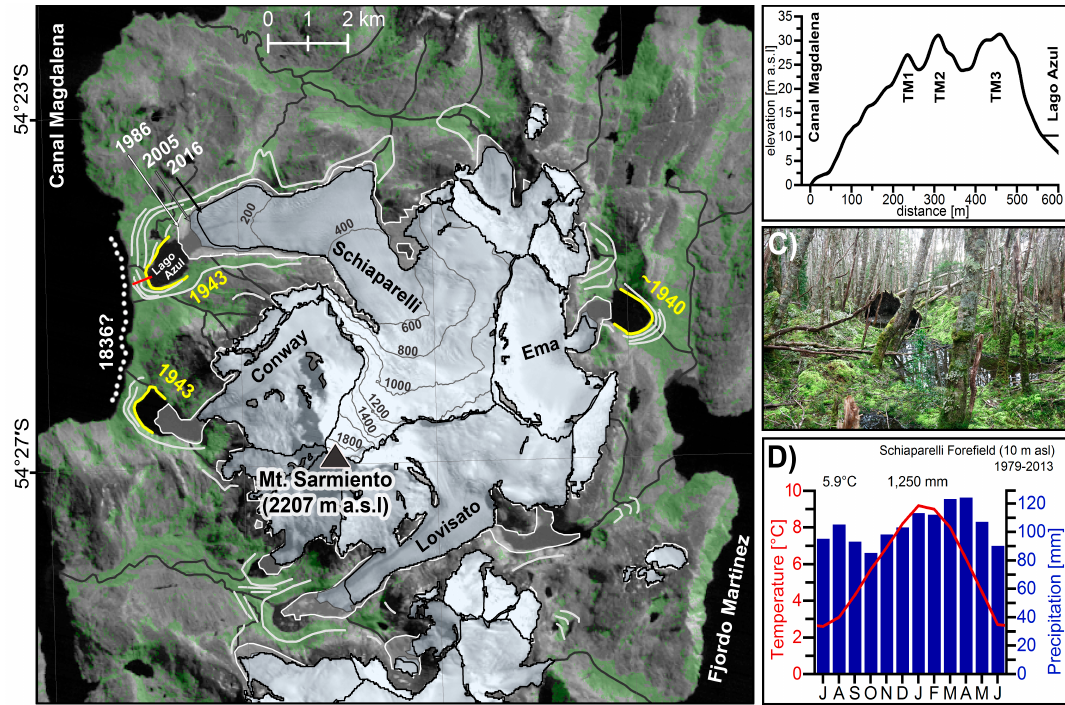
Figure 2. ( A ) Overview of the study site at Mt. Sarmiento, including glacial margins [8,42] and their corresponding moraine ridges (light grey) and forest cover (green [43]). ( B ) Cross-section of the terminal moraine system as indicated by the red bar in (A). Three major terminal moraine ridges were identified (TM1–TM3). ( C ) Peat bog formation between the moraine ridges, colonized with Nothofagus betuloides trees of comparable diameter. ( D ) Climate diagram calculated as a mean of four CHELSA grids cells covering the end moraine [18].